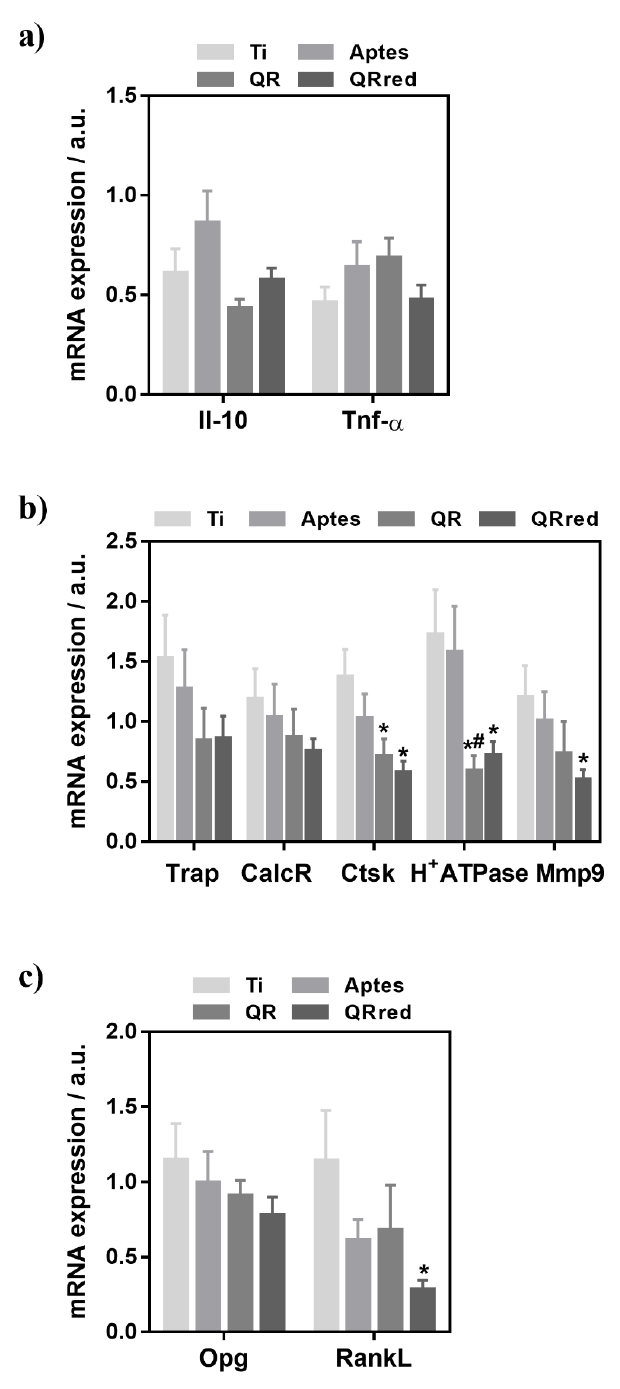
Figure 6. In vivo relative mRNA expression levels of markers related to ( a ) inflammation: the tumor necrosis factor- α ( Tnf- α ) and interleukin 10 (Il-10) ( b ) bone resorption: tartrate-resistant acid phosphatase ( Trap ) and calcitonin receptor ( CalcR ) were analyzed as phenotypic markers, and cathepsin K ( Ctsk ), vacuolar type proton ATPase ( H + ATPase ) and metalloproteinase 9 ( Mmp9 ) as functional osteoclastic markers and, ( c ) osteoblast-osteoclast interaction: osteoprotegerin ( Opg ) and RankL , determined by real time RT-PCR from peri-implant bone tissue on the different quercitrin implant surfaces after 8 weeks of healing. Values represent mean ± SEM, n = 6, a.u. (arbitrary units). The t -test was performed for all markers except for RankL which was analyzed by the Mann-Whitney test: * p < 0.05 vs. Ti, # p < 0.05 vs.